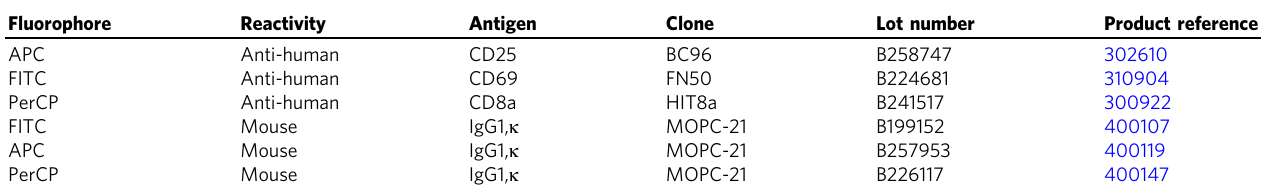
Table 1 Flow cytometry antibodies and isotype controls.